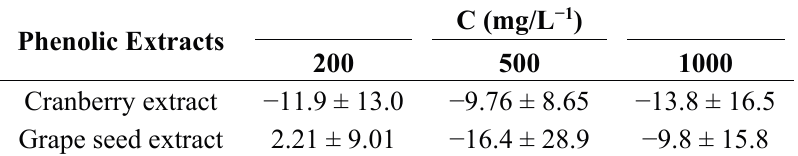
Table 2. Inhibition (%) of the adherence of E. coli ATCC ® 53503™ to ATCC ® HTB4™ cells by phenolic